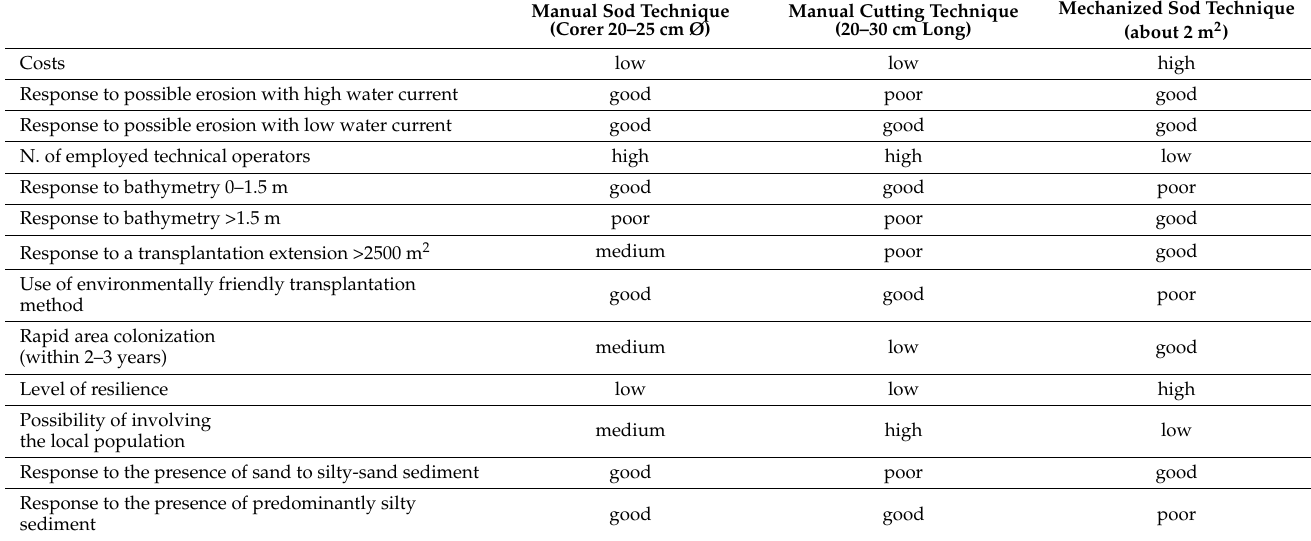
Table 5. List of the main factors (environmental and morphological variables and managerial evaluations) that can affect the transplantation choice and/or